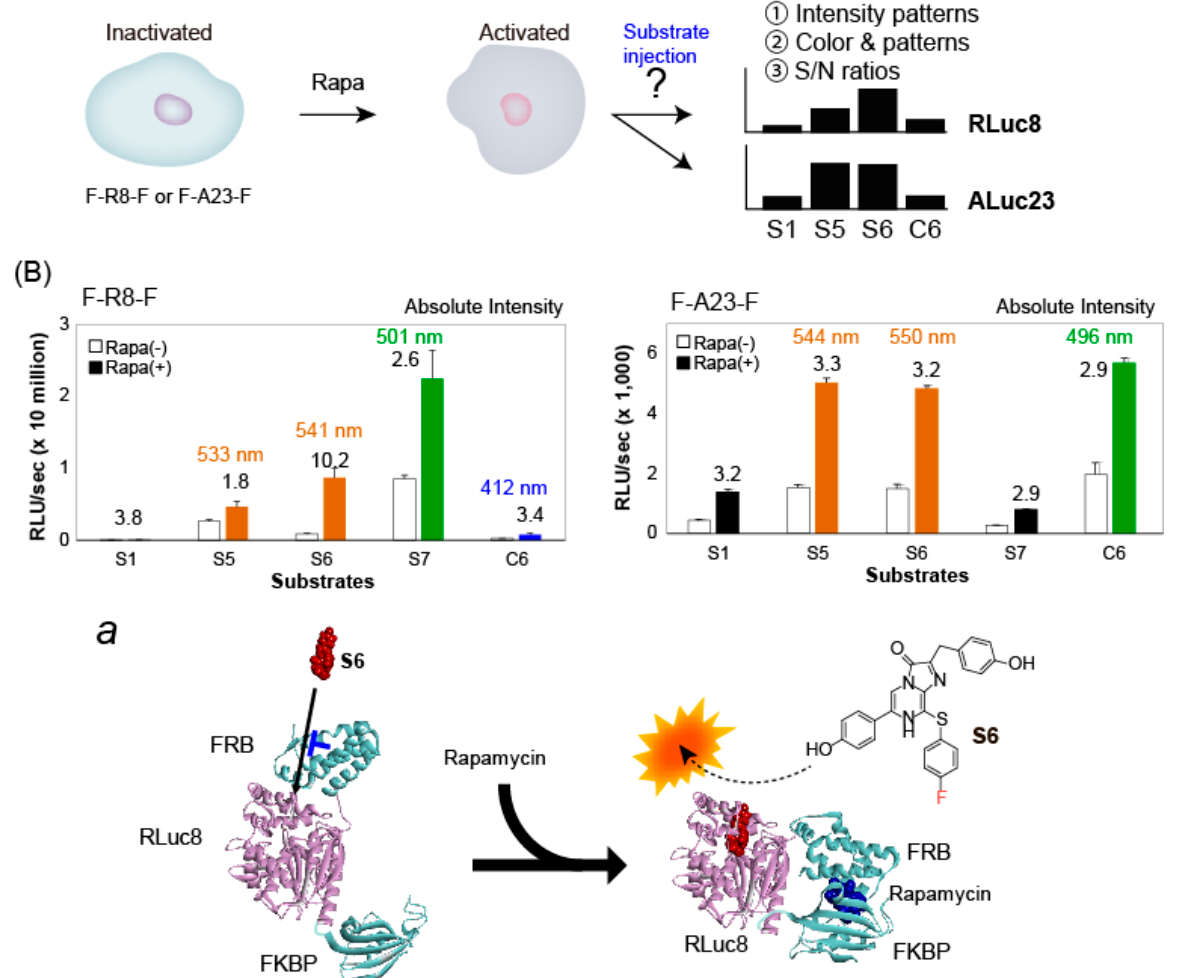
Figure 5. ( A ) Workflow of S-series CTZ-driven assay systems. The cells containing a single-chain molecular probe, F-R8-F or F-A23-F, are stimulated by rapamycin and enhance the BL intensities. The BL intensity patterns (signatures) of F-R8-F, S/N ratios, and the colors according to the substrates are unique. ( B ) The BL intensity patterns (signatures) of F-R8-F (left) and F-A23-F (right) according to the substrates in the presence or absence of rapamycin. The open and closed color bars represent the BL intensities in the absence (-) or presence (+) of rapamycin (rapa), respectively. Inset a illustrates the model structure of F-R8-F and its working mechanism triggered by rapamycin. The FKBP and FRB structures (with rapamycin) were obtained from the Protein Data Bank (PDB: 1FAP) [33]. The rapamycin-activated FRB–FKBP-binding complex was manually deployed through a consecutive linkage of the components.